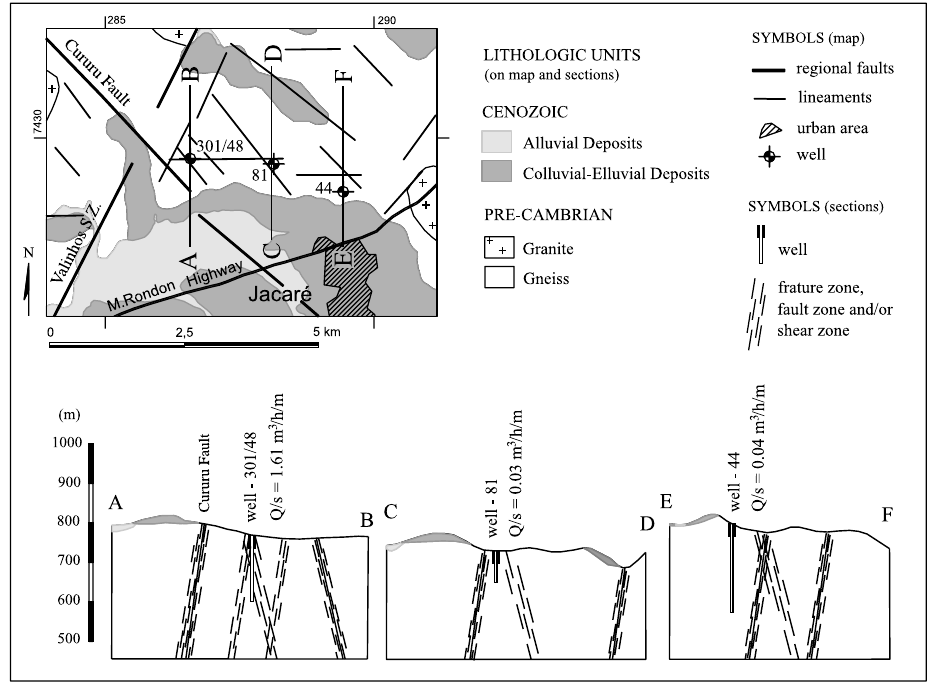
Fig. 9 – The second case study, in the neighborhood of Jacaré District. The high productivity of one well is associated with NW–SE and E–W